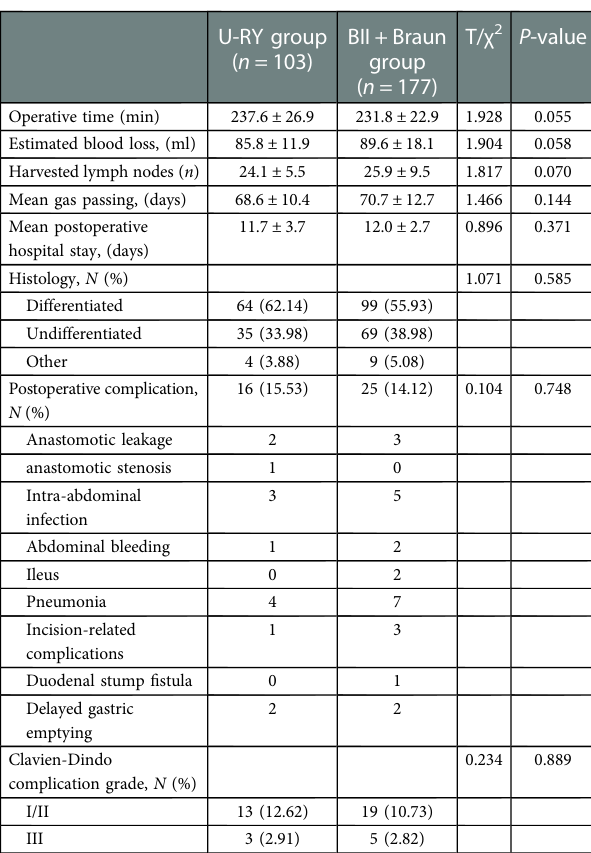
TABLE 2 Comparison of postoperative conditions between the two